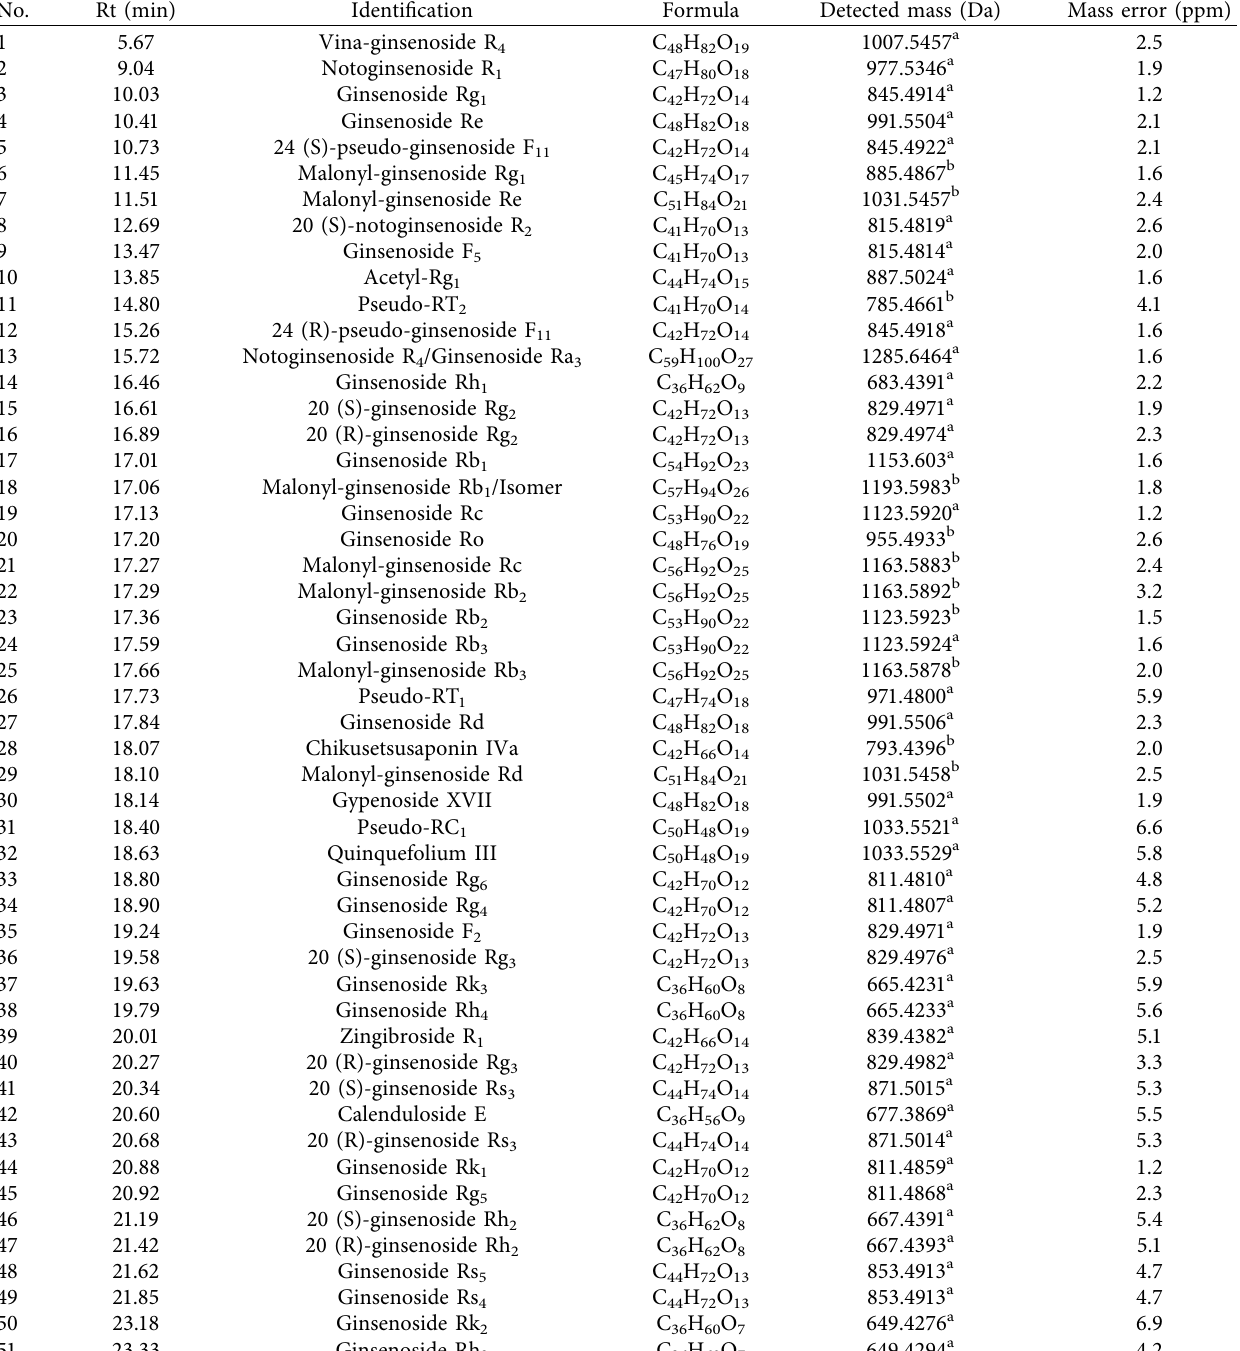
Table 1: Compounds identified from American ginseng by natural drying, steam drying, and vacuum